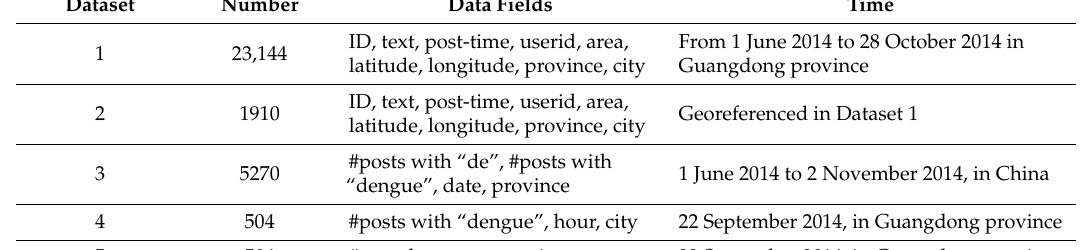
Table 1. Dataset list.